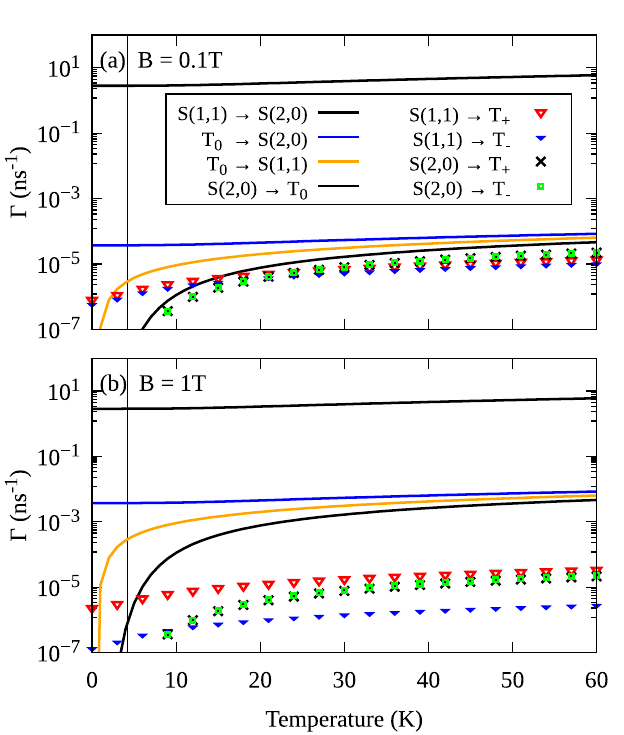
26 kV/cm. The vertical lines =